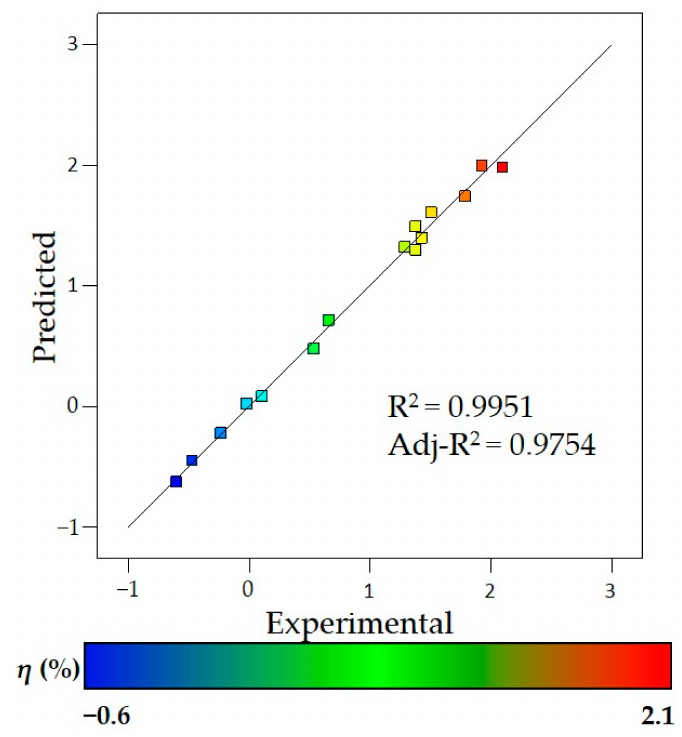
Figure 6. Relationship between experimental and predicted η values, the points are colored by η values and the color is consistent with 3D response surface in Figure